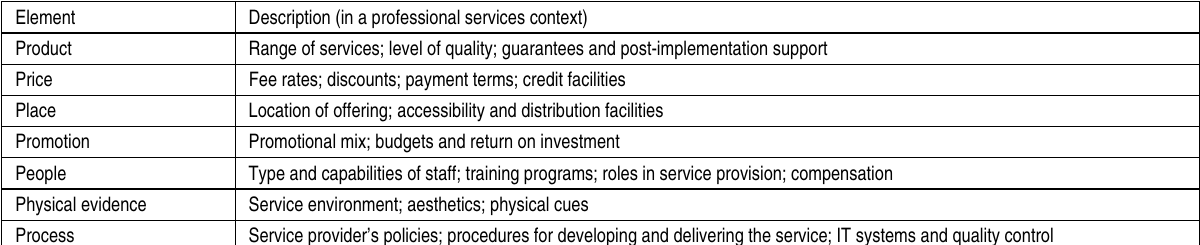
Table 1. Seven Ps of professional services